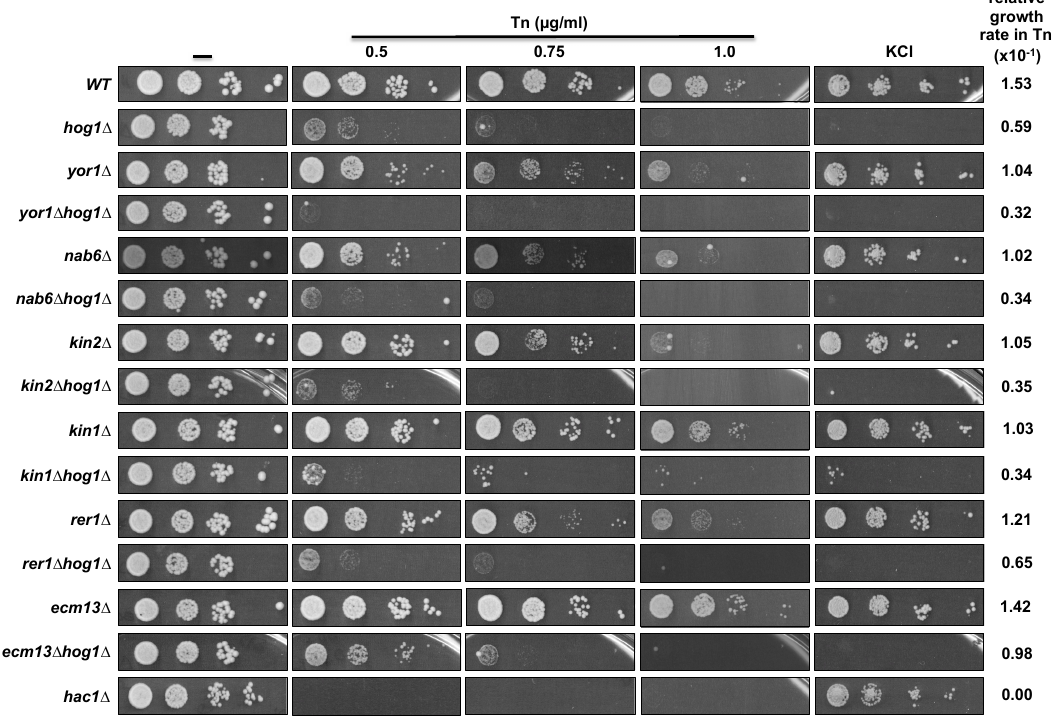
Figure 4. Effect of the inactivation of the suppressor genes on Tn sensitivity and their epistatic interaction with HOG1 . Single mutants of each suppressor ORF (obtained from the EUROSCARF collection) and the double mutants (constructed as described in the methods section), were tested in different concentrations of Tn or 1M KCl. Yeast cells were grown in YPD and plated as described in Figure legend 2B. Plates were incubated at 30 °C for 72 h and scanned. (*) Relative growth rate was determined from growth at 0.5 μ g/mL Tn as described in Figure legend 2.